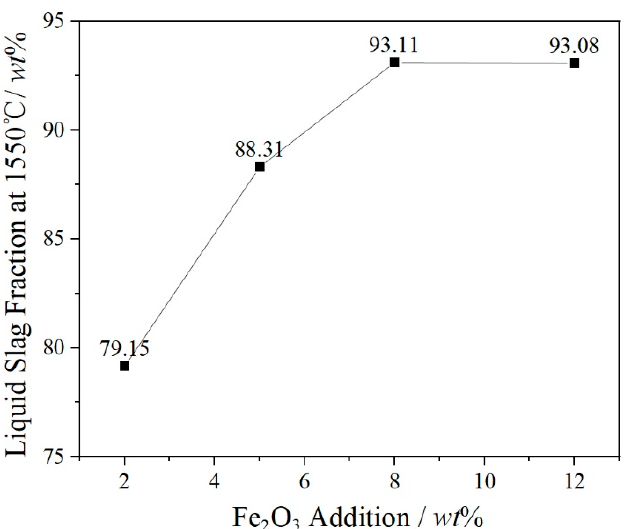
Figure 4. Effect of Fe 2 O 3 on liquid content in CaO-SiO 2 -MgO-Al 2 O 3 -Cr 2 O 3 system at 1550 °C .